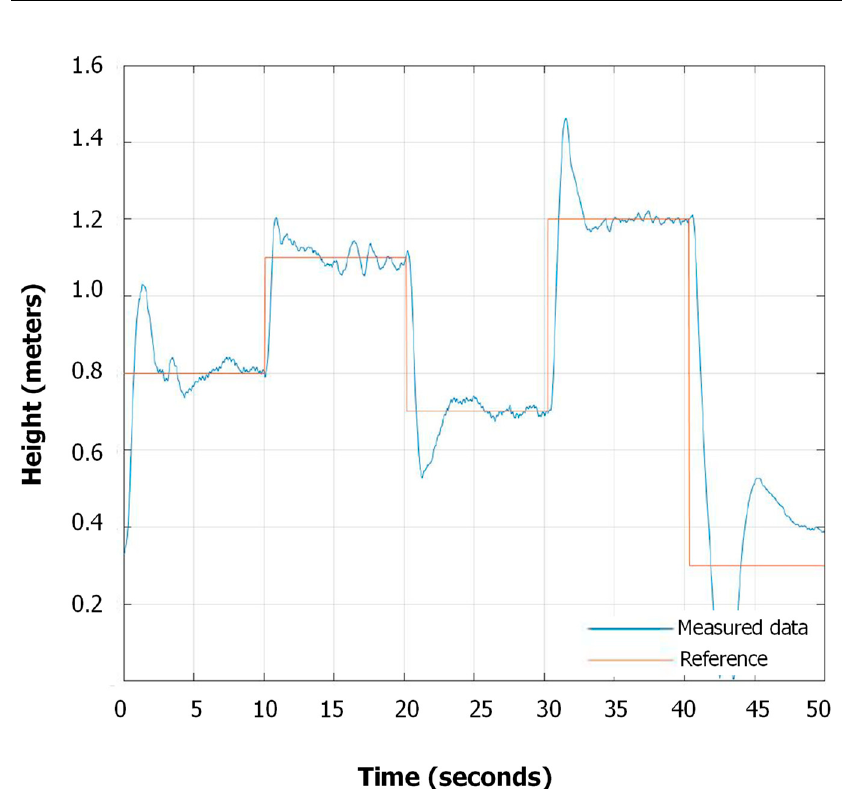
Figure 3. Experimental results when following the predefined trajectory without any additional load according to the AMIGO method.